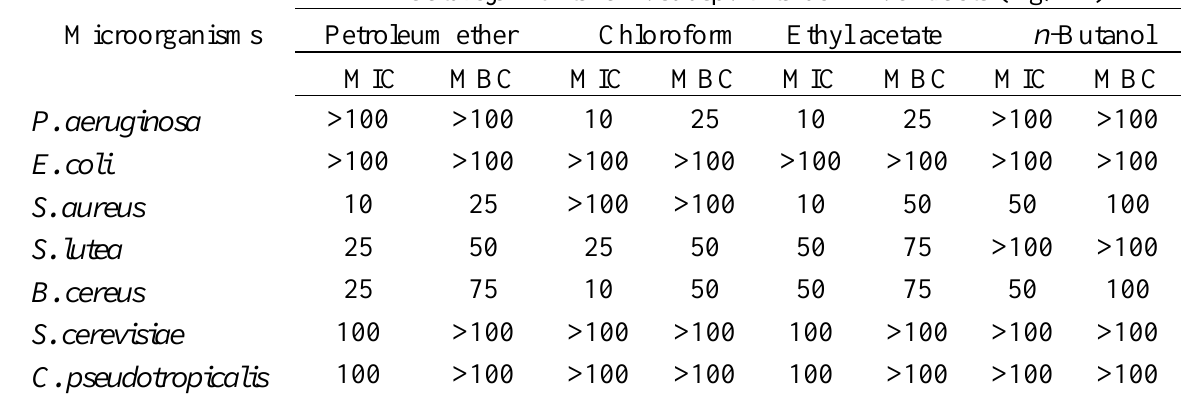
Table 2 . Minimum inhibitory concentrations (MIC) and minimum bactericidal concentrations (MBC) of different Satureja montana L. subsp . kitaibelii